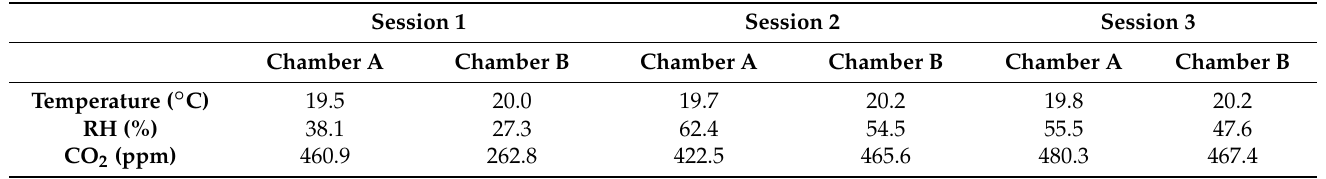
Table 2. Average temperature, relative humidity (RH), and CO 2 concentration inside of the Chambers A and B during the execution of the sessions.